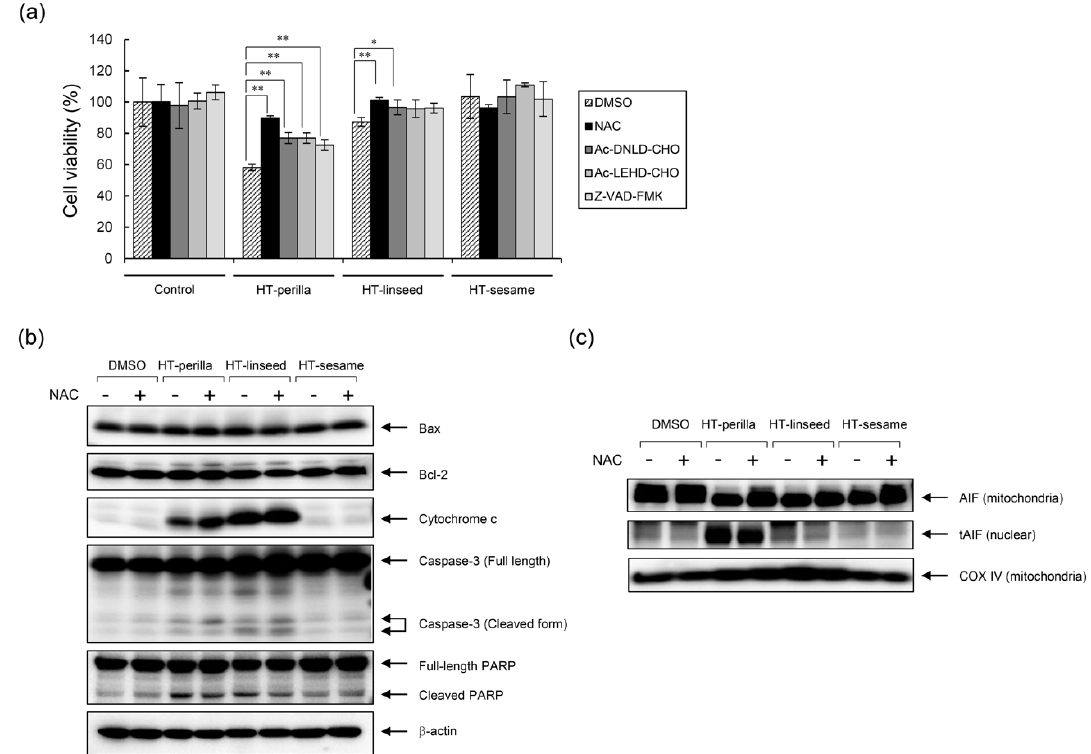
Figure 5. Analysis of the apoptotic mechanism induced by heat-treated oils. ( a ) The anti-apoptotic effect of caspase inhibitors and an antioxidant. SH-SY5Y cells were pretreated with a caspase-3 inhibitor (Ac-DNLD-CHO, 100 μ M), caspase-9 inhibitor (Ac-LEHD-CHO, 100 μ M), pan-caspase inhibitor (Z-VAD-FMK, 20 μ M), or NAC (10 mM) for 12 h, and then exposed to heat-treated oils for 24 h. Cell viability was measured using a Cell Counting Kit-8. One-way ANOVA with Dunnett’s test was used. * p < 0.05 and ** p < 0.01 compared with control (DMSO). Results are expressed as mean ± SD (n = 3). (b, c) SH-SY5Y cells were pretreated with NAC (10 mM) for 12 h, and then incubated with heat-treated oils (1 mg/mL) for 24 h. ( b ) Western blot analysis was performed using the corresponding specific antibodies. Representative results of at least three experiments are shown. ( c ) Mitochondria and nuclear fractions were separated by subcellular fractionation. Western blotting was performed on mitochondrial and nuclear fractions using anti-AIF, which recognizes both truncated (tAIF) and untruncated forms of AIF. COX IV was used as loading control for the mitochondrial fraction.